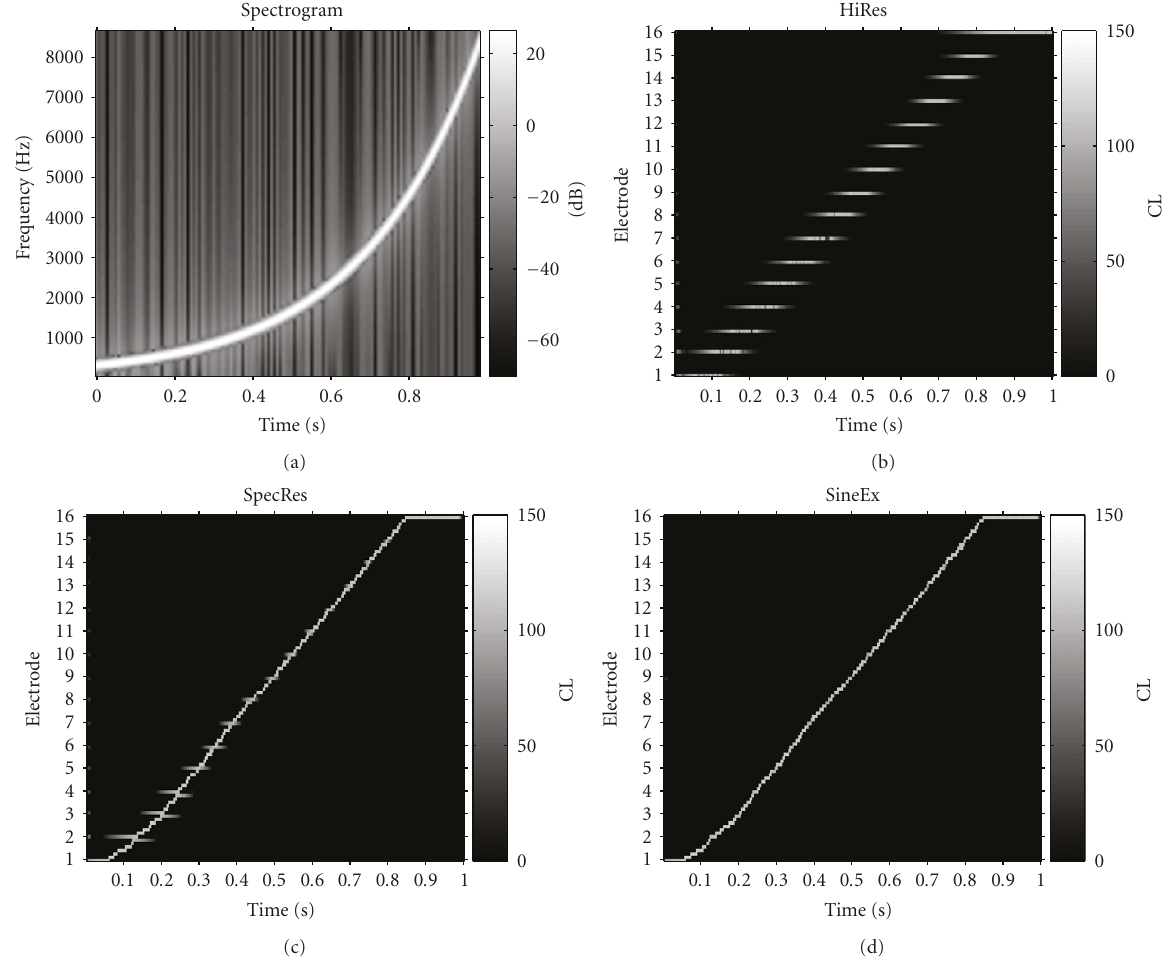
Figure 6: Stimulation patterns obtained with (b) HiRes, (c) SpecRes, and (d) SineEx in quiet when the input signal is a sweep tone of 1 millisecond of constant amplitude (70dB) and frequency varying from 300 Hz until 8700 kHz shown in (a). The horizontal axis represents time in seconds, and the vertical axis represents the electrode location. The level applied in current level (CL) is coded with the colors given in the color bars. The location of excitation is obtained as presented in Section 2.4.